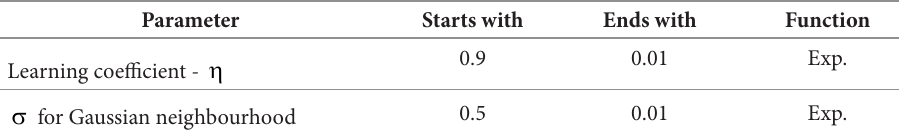
Table 2. Learning